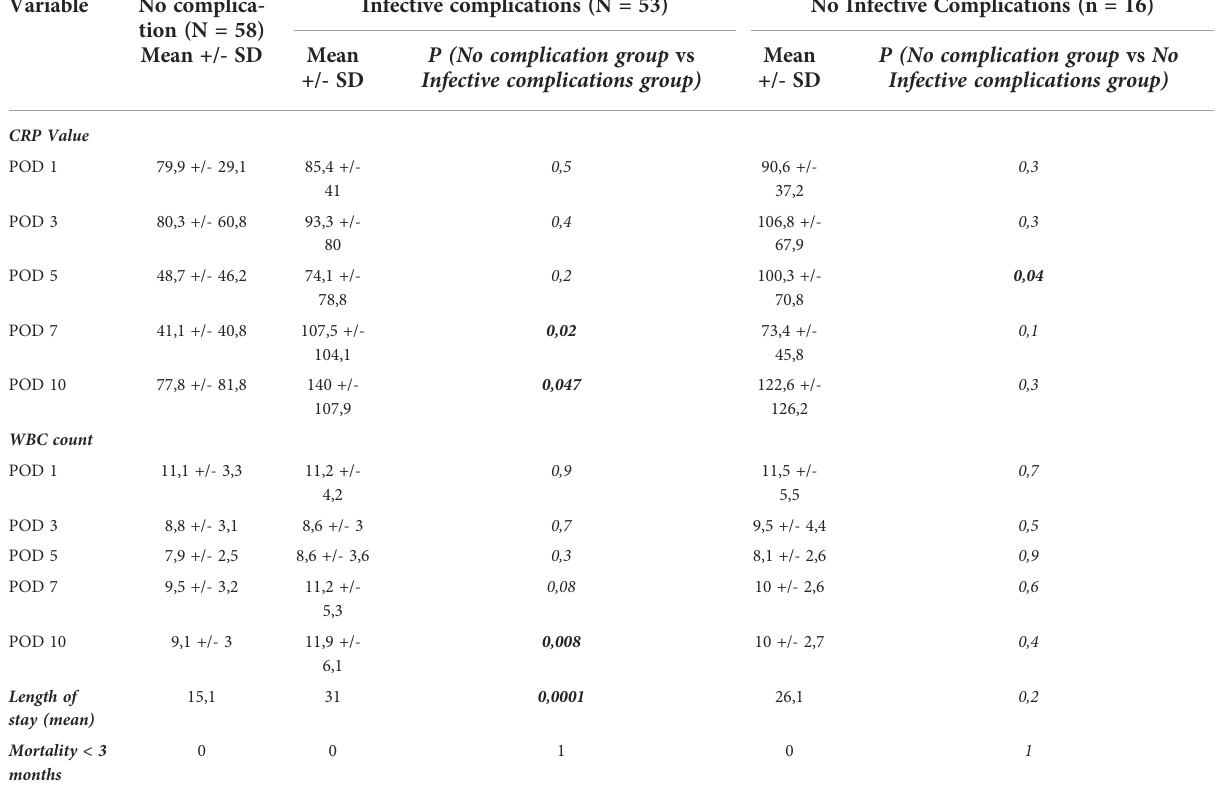
TABLE 3 Postoperative values of CRP and the WBC count in the 3 groups. Variable